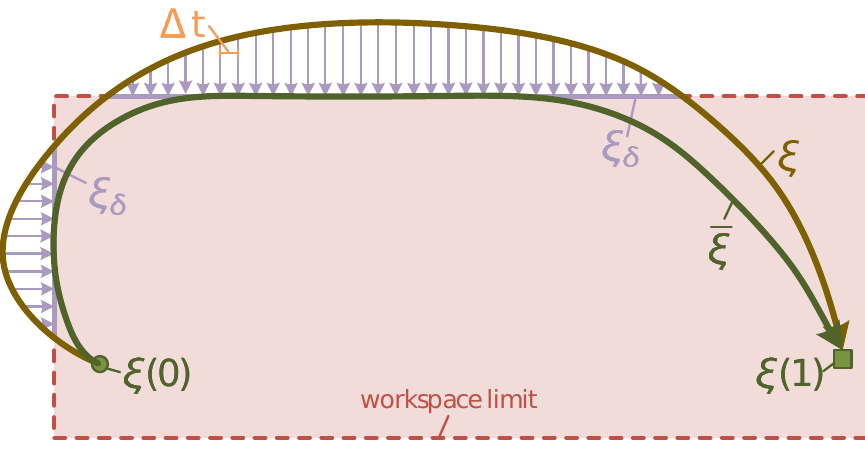
The smooth projection technology for workspace limit demonstrated in two-dimensional